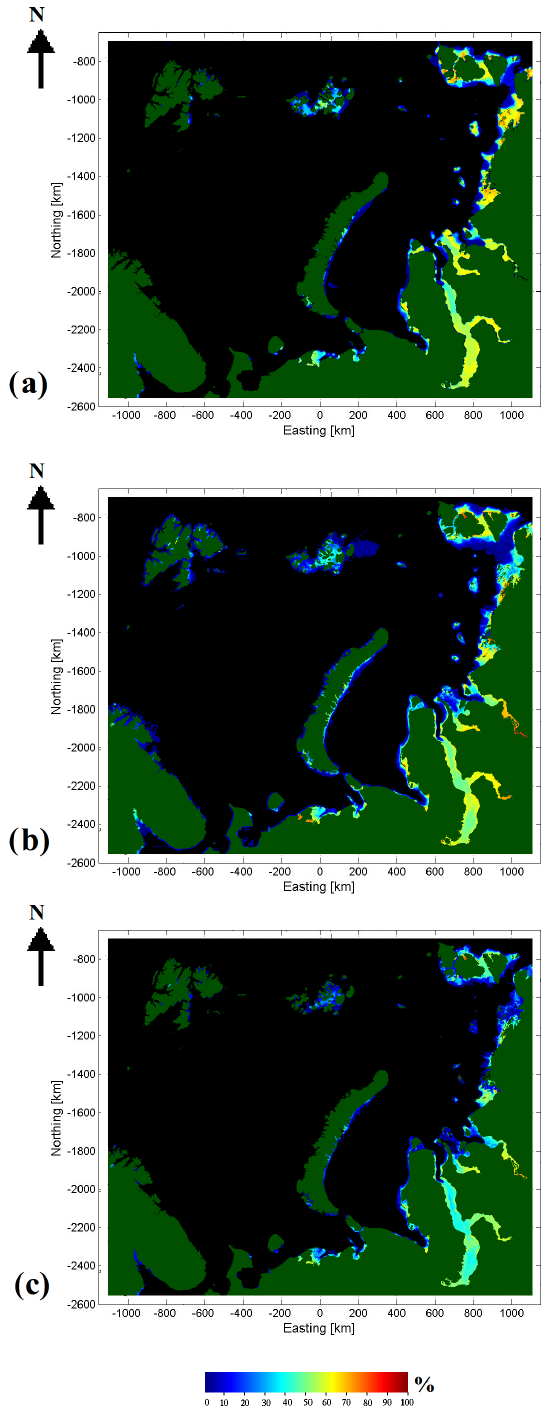
Figure 11. Temporal LFI coverage (percentage) during the period from 1 November 2015 to 31 October 2016 based on the weekly AARI ice charts (a) , daily FMI-A (b) and daily FMI-B (c) . The val- ues (percentages) indicate the time fraction of the one-year period in which there was LFI at each grid